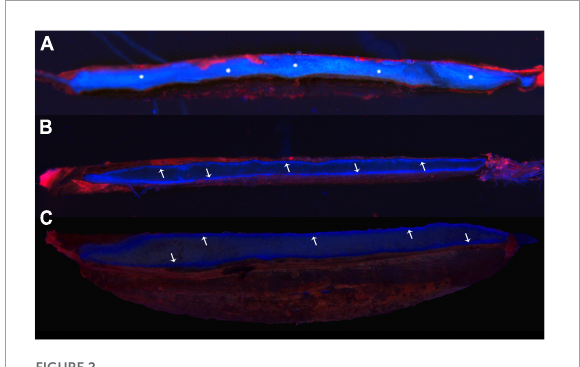
FIGURE2 Fluorescence staining indicates the osmotic properties of the seed coat. (A–C) Samples at 8, 18, and 28 dpa, respectively. The snowflakes showed that the fluorescent dye infiltrated into the inside seed, and the arrows indicated that the dye was blocked outside the seed, forming a fluorescent